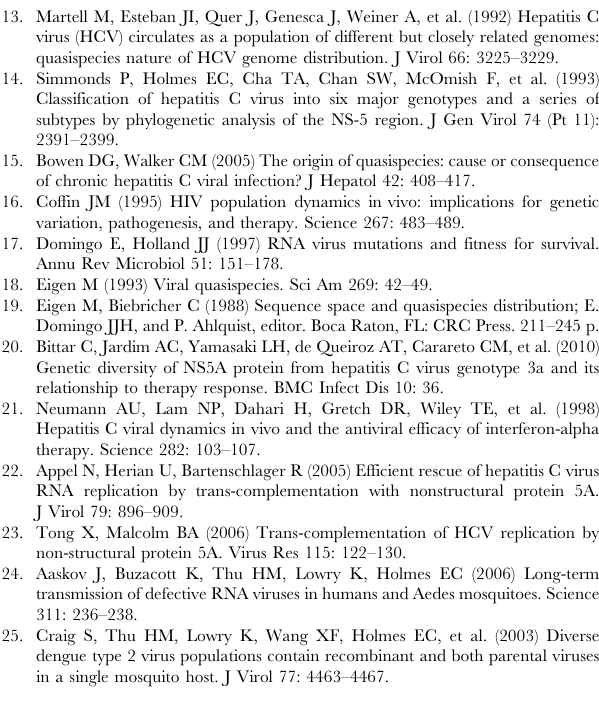
Figure S1 Graphic representation of the time-points used for treatment follow-up. The red circles represent the time-points when the sequences were used for the analysis from this study. P145 were from a previous study detailed in Bittar et al (2010). (TIF) Table S1 Mann-Whitney statistical test on distances between each time-point. A. P07; B. P60; C P75; D. P145; E. P20; F. P82; G. P109; H. P119. In red differences that were not significant (significance p , 0.005). Table S2 Primers used on PCR and NESTED-PCR reactions. *published in Bittar et al